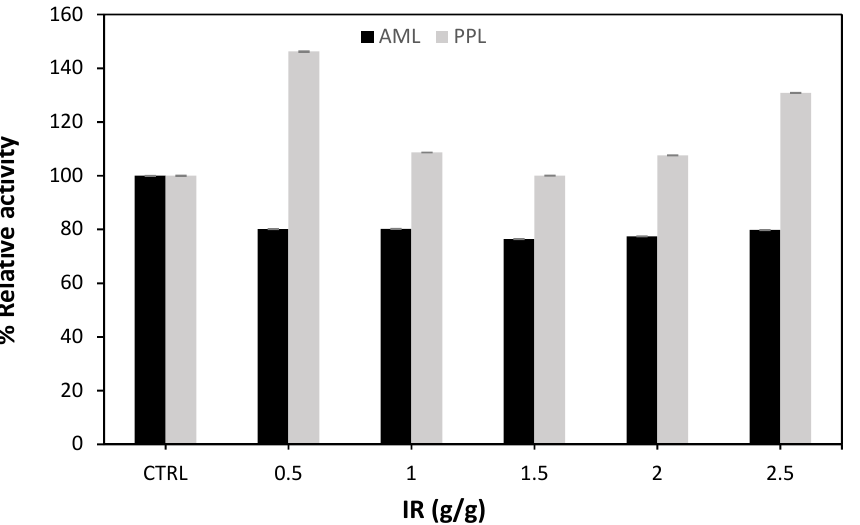
Figure 4. Effect of impregnation ratio (samples A3 and A6–A9) on relative activity for two types of immobilized lipases, Amano lipase (AML) and porcine lipase (PPL), compared to the free enzyme (CTRL).